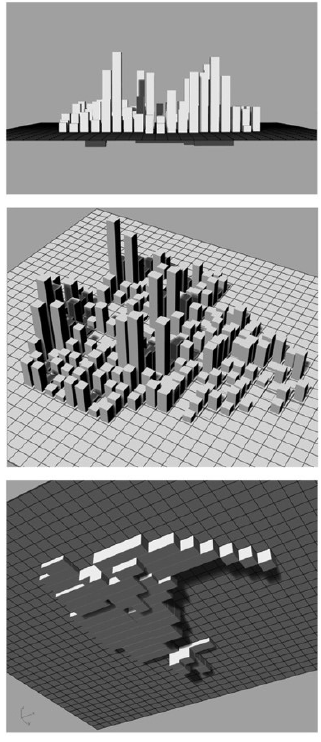
Figure 7. Parametric modelling for the volumetric morphology of Tsim Sha Tsui